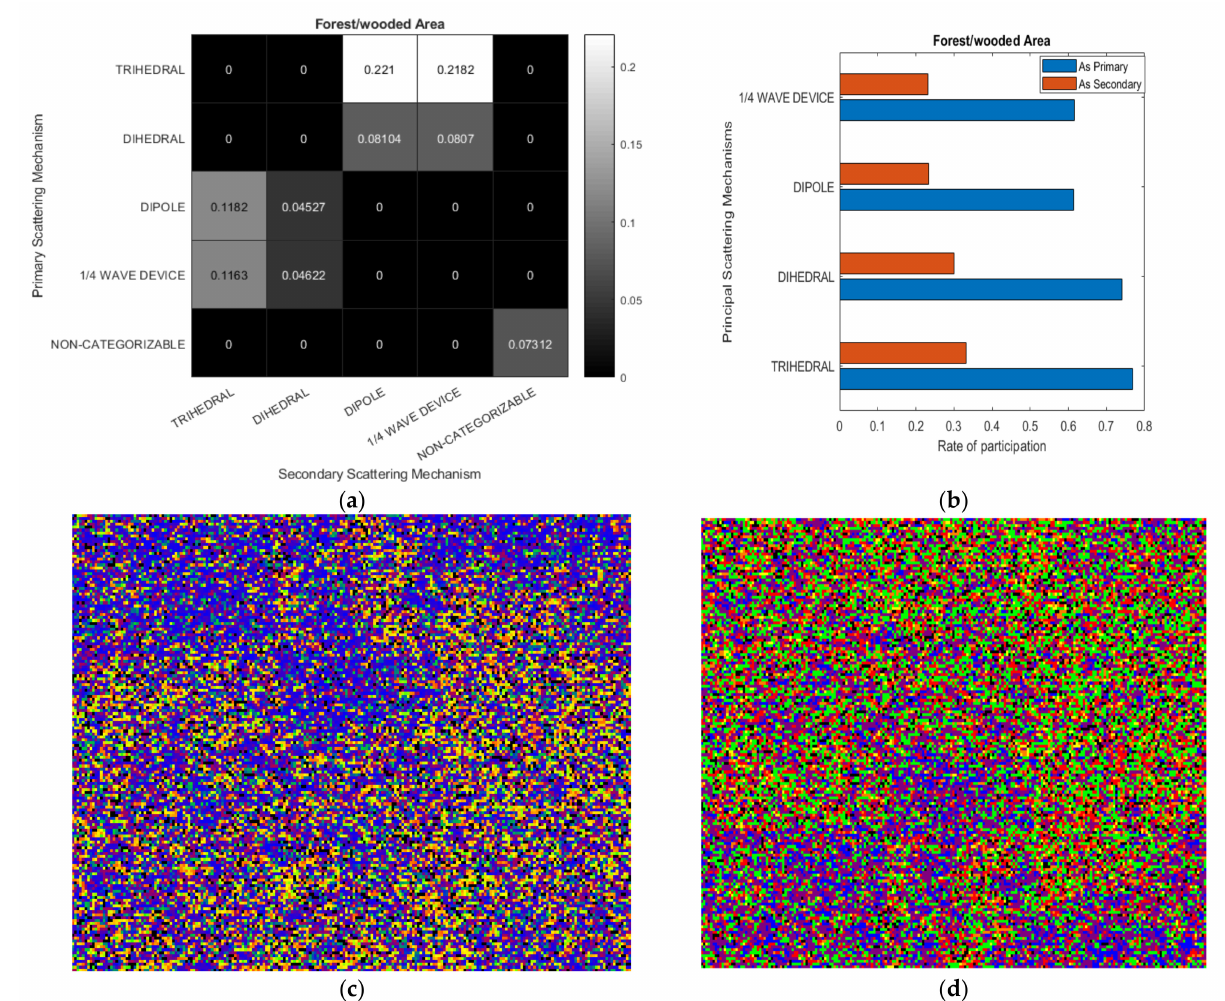
Figure 9. Heatmap ( a ) of primary-secondary scattering pairs and bar diagram ( b ) with the rate of contribution (strength) either as primary or secondary scatterer for each mechanism in forest/wooded area. ( c ) color representation of each PolSAR cell using the double scatterer method. ( d ) color representation of each PolSAR cell using the Cameron’s CTD